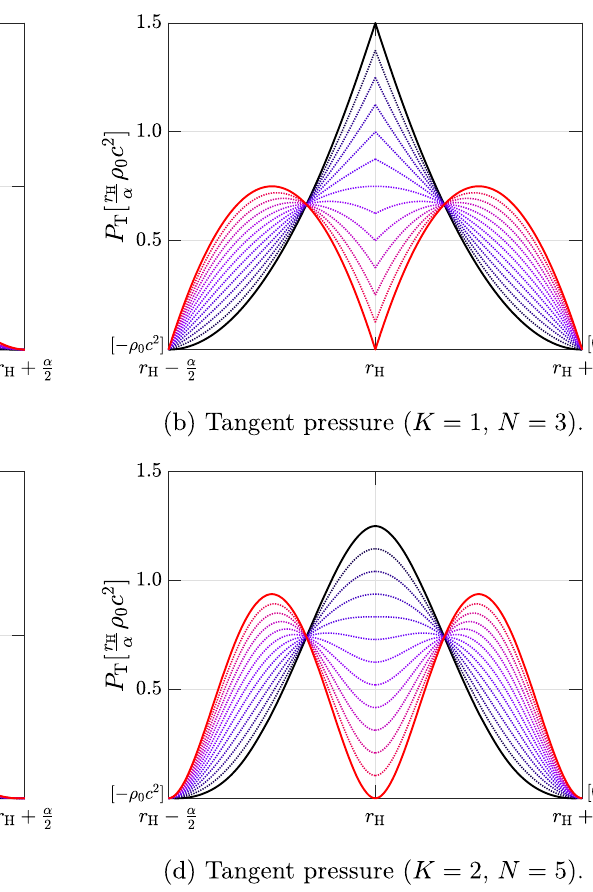
The solid curves represent the limiting allowed curves for which ρ (cid:5) ≤ 0 everywhere, for the respective maximum order of continuous metric derivatives. Upper panels : the metric, its first and second derivatives are continuous everywhere, that is K = 1. We considered N = 3 and ( 3 ) ∈ [− 4 , 8 ] . Lower each curve corresponds to a different value of A 2 panels : The metric, its first, second and third derivatives are continu- ous everywhere, that is K = 2. We considered N = 5 and each curve ( 5 ) = A ( 5 ) ∈ [− 96 , 24 corresponds to a different value of A 1 2